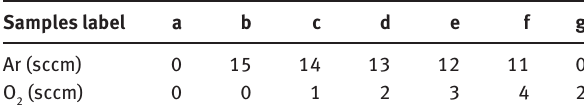
in the diamond growth stage. 2